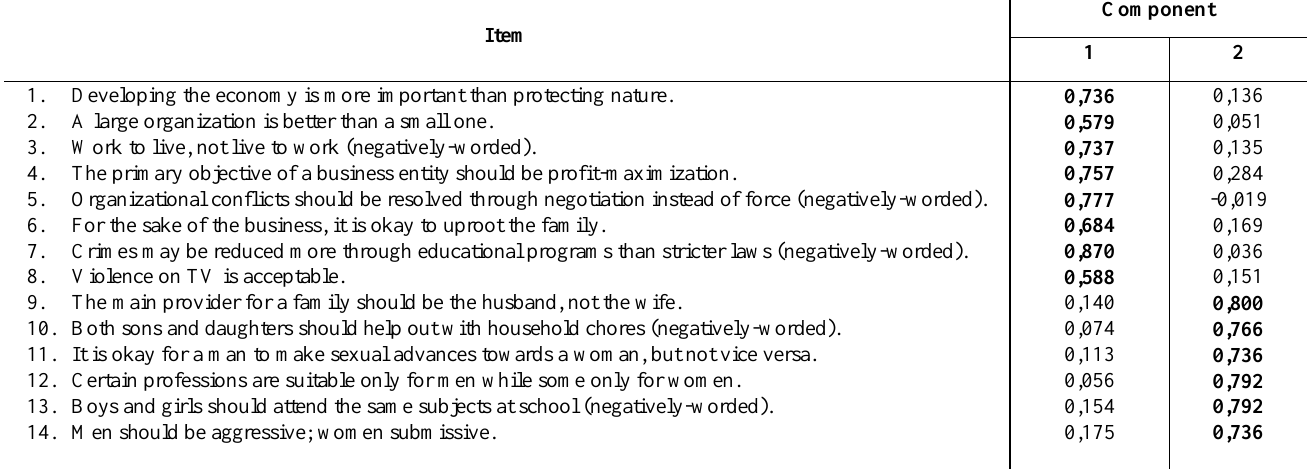
Table 2: Rotated component matrix for the gender differentiation-ego orientation scale Item